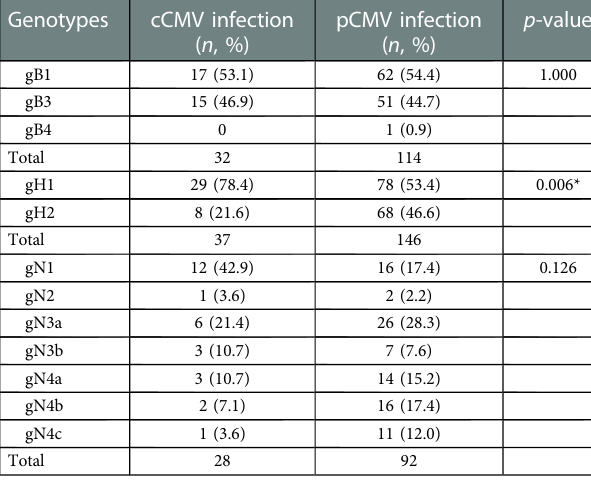
TABLE 1 Distribution of gB, gH and gN genotypes among symptomatic cCMV and pCMV infected children. Genotypes